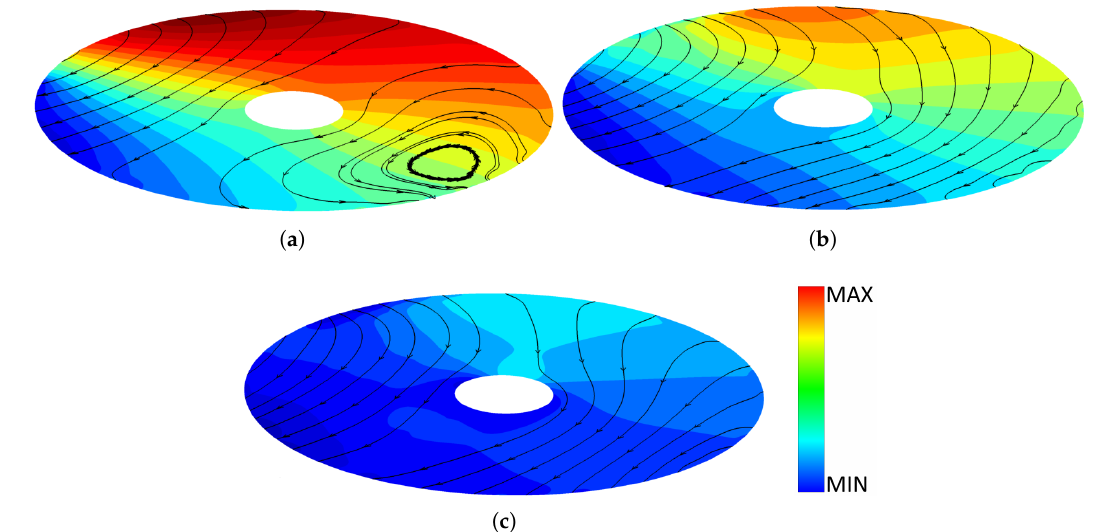
Figure 4. Pressure contour for various axial gap: ( a ) h/H = 0.00886; ( b ) h/H = 0.0177; and ( c ) h/H = 0.0354.